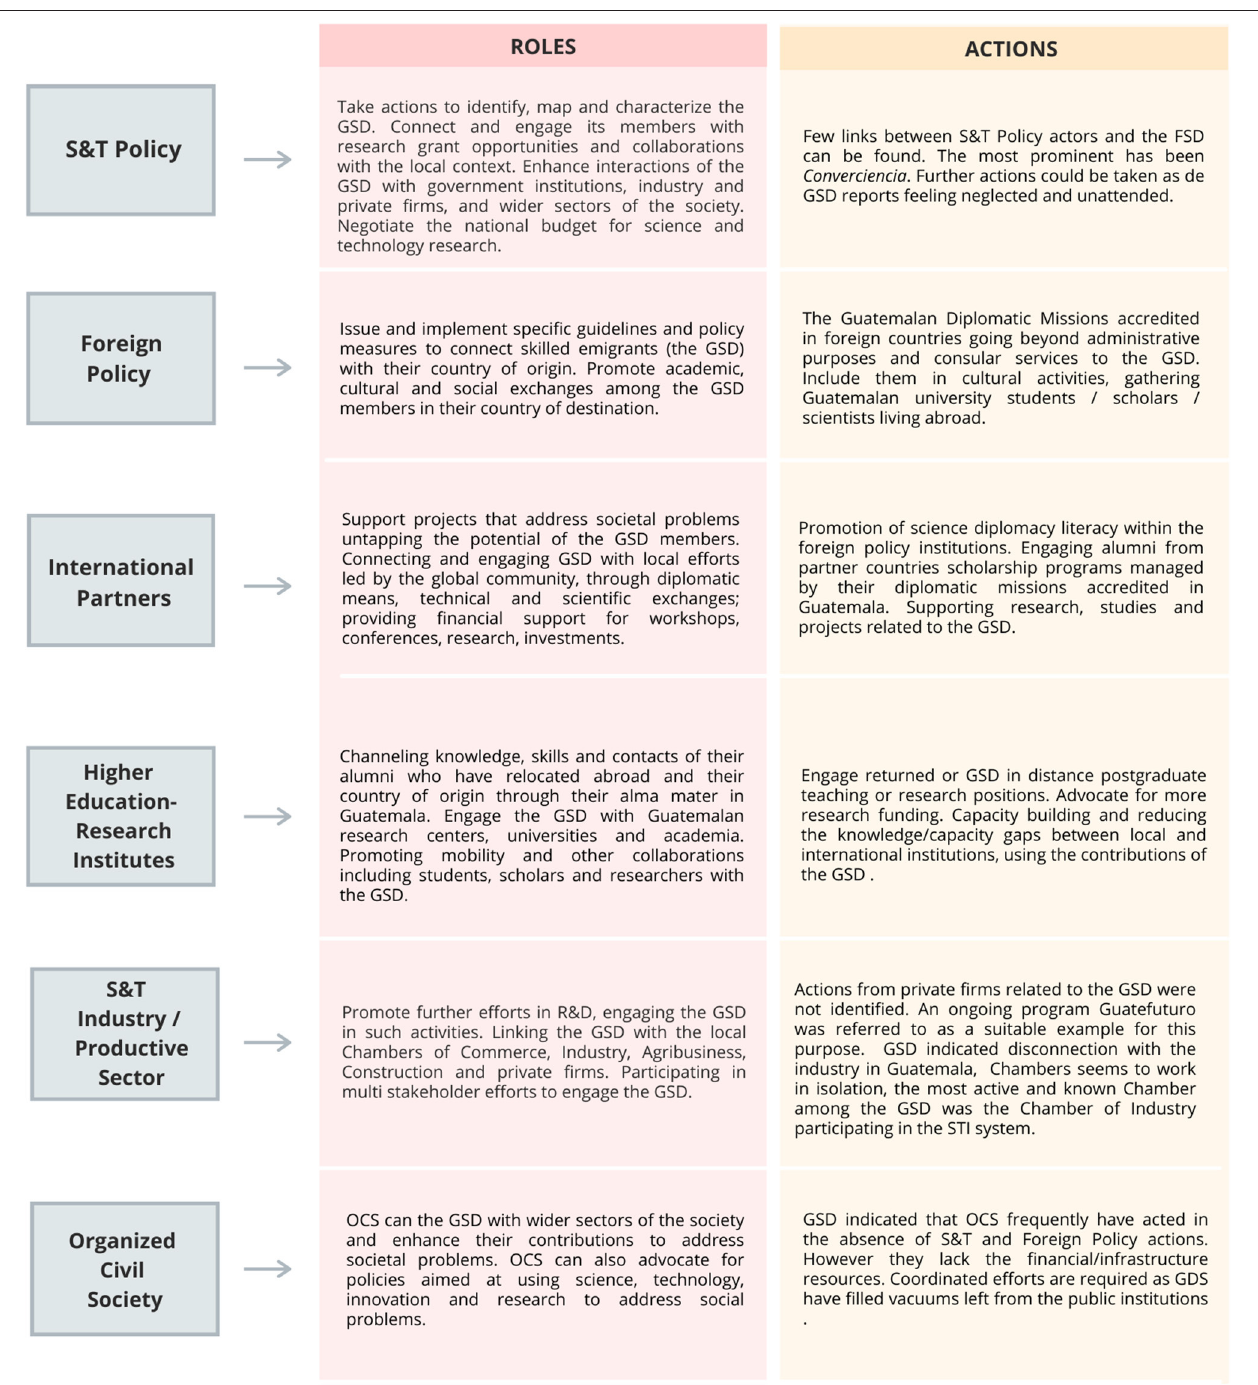
FIGURE 6 | Stakeholders—roles and actions identified by participants in engaging the GSD (September 2019-February 2020).